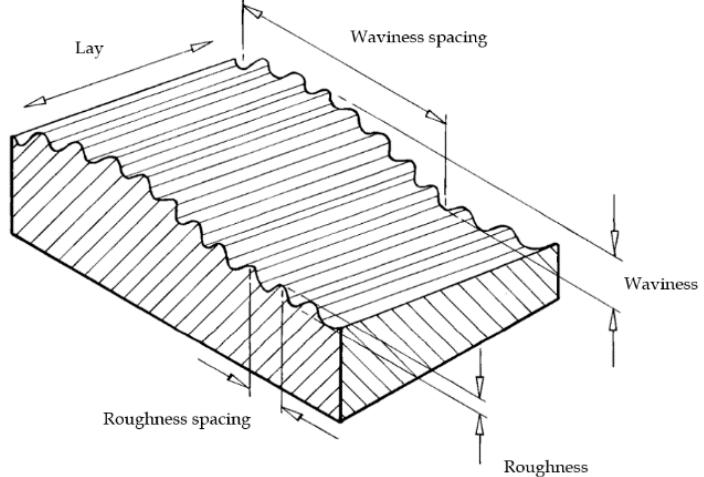
Figure 7. Schematic representation showing the roughness, waviness and lay on a surface [55]. Reprinted with permission from [55]; 2014 NPL.